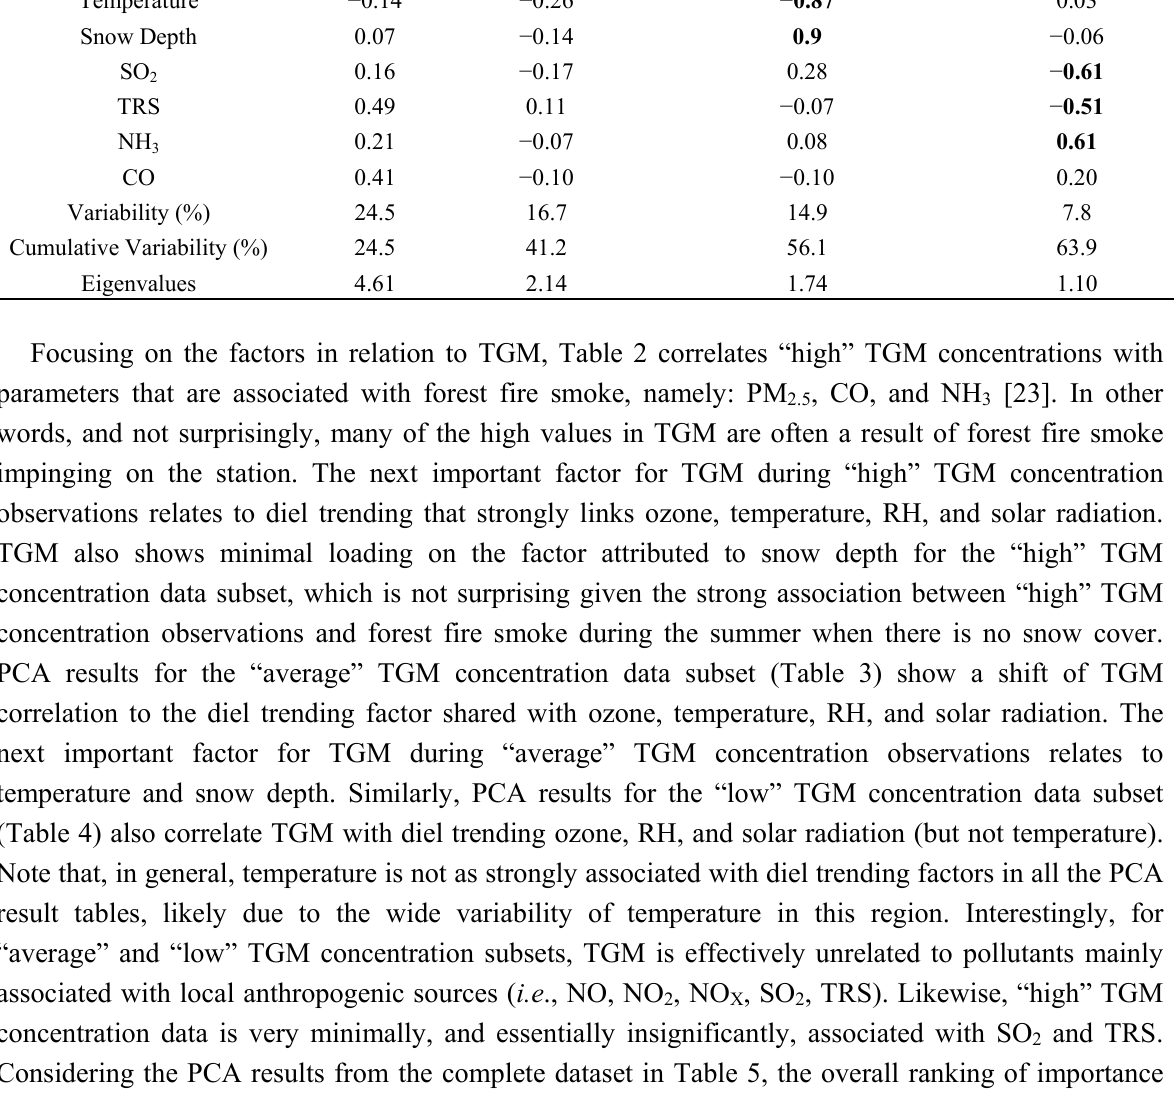
Industrial Sulphur & NH